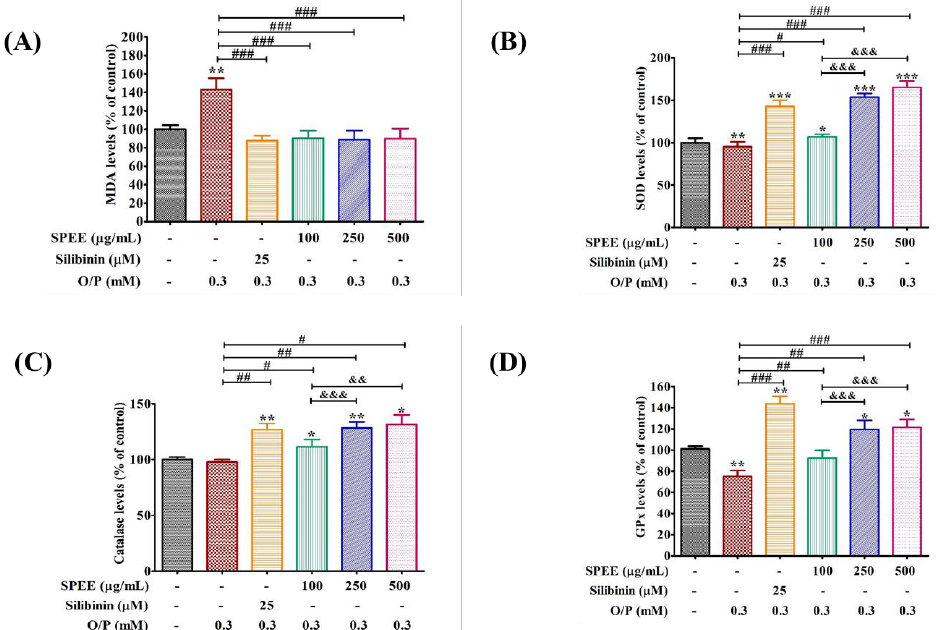
Figure 6. The effects of SPEE on O/P-inhibited antioxidant activities in HepG2 cells. HepG2 cells were co-treated with 0.3 mM O/P and SPEE at 100, 250 and 500 μ g/mL for 24 h. SPEE inhibited the O/P-induced MDA production ( A ), and increased the antioxidant enzyme activities of SOD ( B ), catalase ( C ) and GPx ( D ). Silibinin (25 μ M) was used as the positive control. Values are expressed as mean ± SD from triplicated experiments ( n = 3). * p < 0.05, ** p < 0.01 and *** p < 0.001 vs. the control group. # p < 0.05, ## p < 0.01 and ### p < 0.001 vs. the O/P group. && p < 0.01 and &&& p < 0.001 vs. the O/P 0.3 mM + SPEE 100 µ g/mL